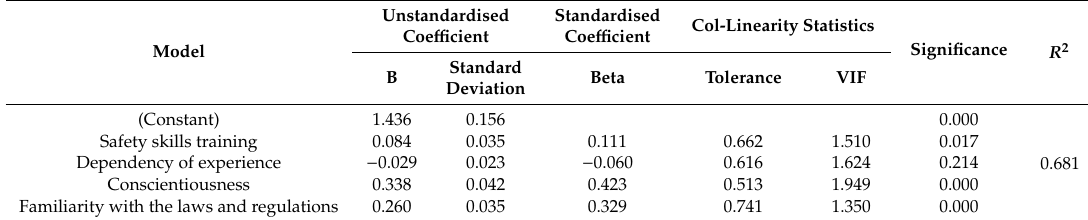
Table 14. Linear regression with multiple elements.